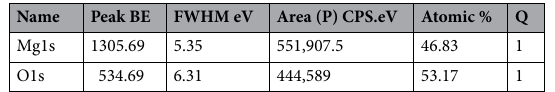
Table 2. XPS data of biosynthesized RcNps.